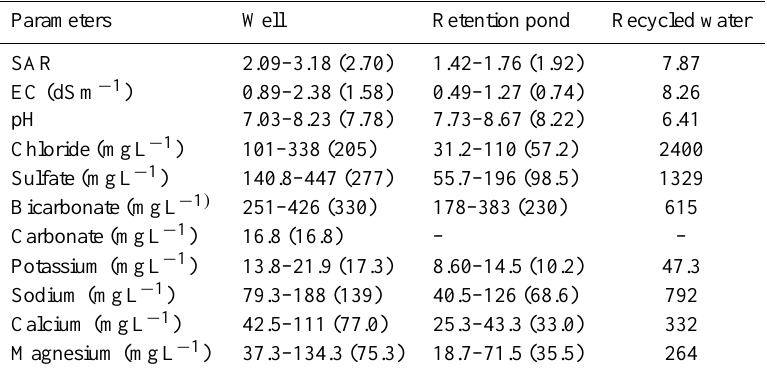
Table 3. Typical concentrations ranges (mean) of selected water quality indicators from well, retention pond, and recycled wastewater sources summarized from four different golf courses in the city of Lubbock, Texas, USA, from 1991 to 2013 (number of years = 15, 4, and 1 for well, retention pond, and recycled wastewater sources,